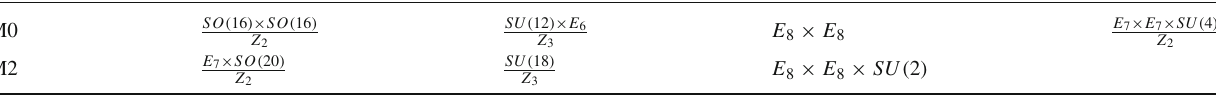
Fig. 1 E 7 × E 7 and SO ( 24 ) × SU ( 2 ) 2 Z fiber of the polytope M 476. The points in blue draw the extended Dynkin diagram of E 7 s on the left, SO ( 24 ) 2 on the right. The contribution of SU ( 2 ) s from the fiber are symbolised by red points. The fiber being F13 there is an additional contribution of 1 Z Table 1 Gauge groups for polytopes with Picard 19. Columns represent the inequivalent fibers (cid:6) ( 2 ) dividing the dual N # of M # into two parts. Additional contributions of U ( 1 ) factors should be considered so that the gauge group is of rank p − 2 where p is the Picard